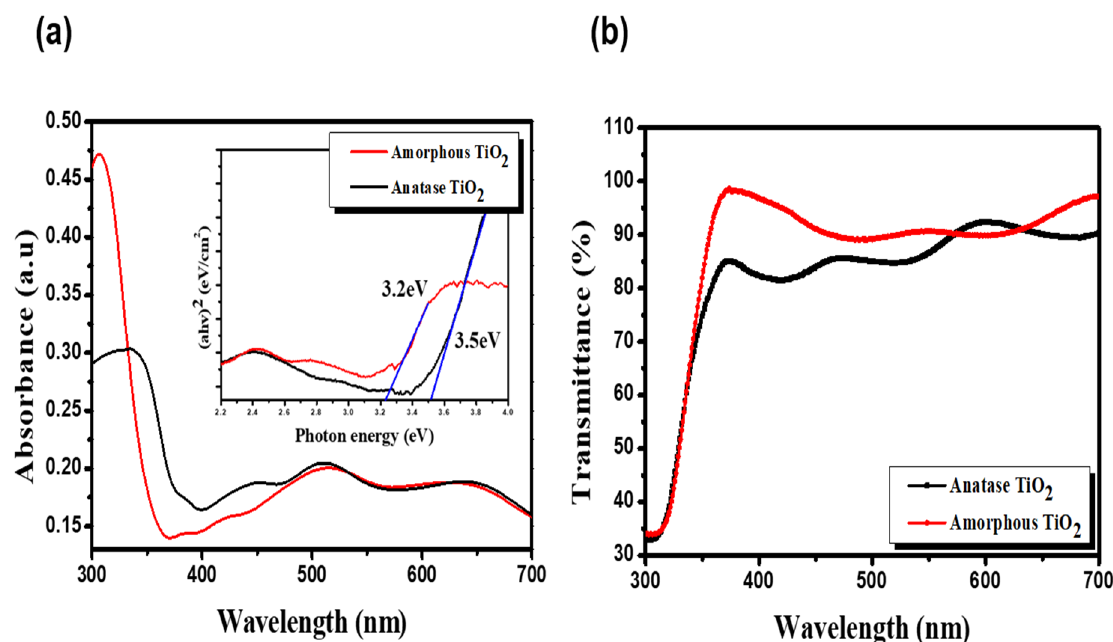
Figure 4. ( a ) Absorbance spectra and ( b ) transmittance of TiO 2 monolayers using An- (dot-line) and Am-TiO 2 (black-line) nanosphere monolayers. Am-TiO 2 (black-line) nanosphere